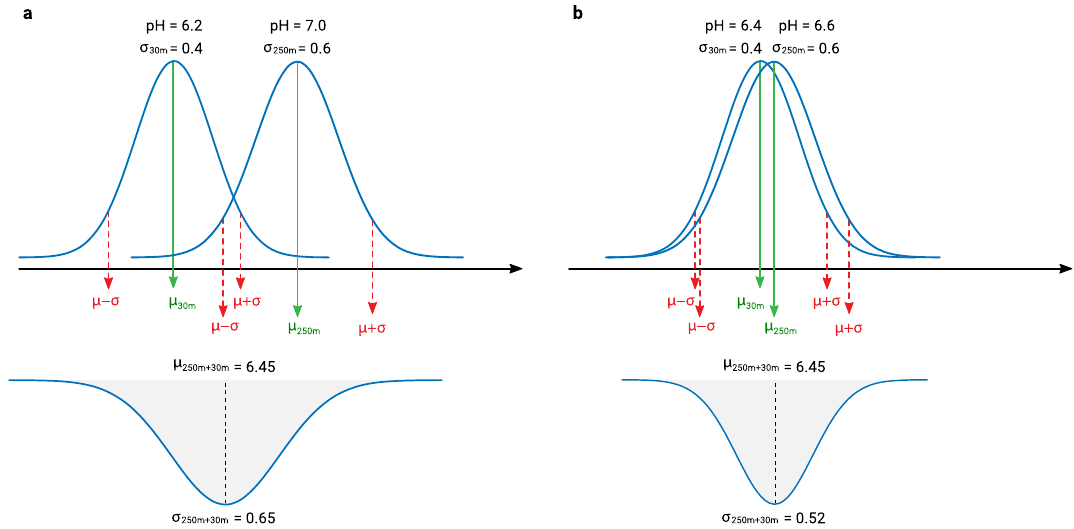
Figure 9. Schematic example of the derivation of a pooled variance ( σ 250m + 30m ) using the 250 m and 30 m predictions and predictions errors with ( a ) larger and ( b ) smaller differences in independent